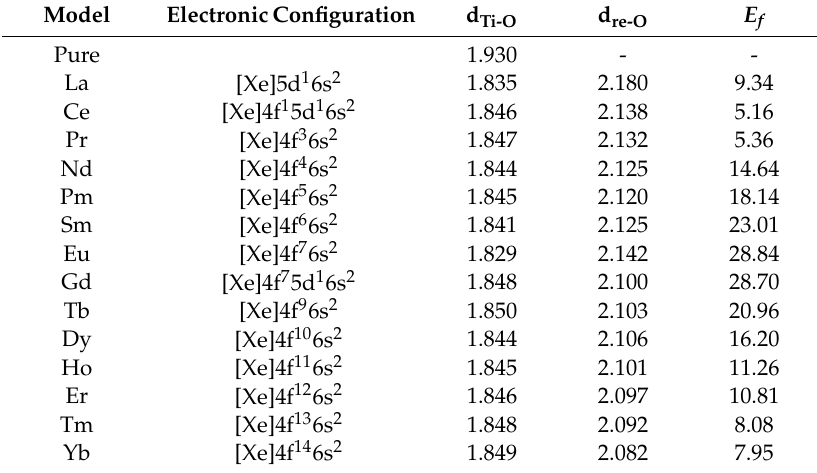
Table 1. Calculated bond length (Å) and defect formation energies (eV) of pure and doped TiO 2 .